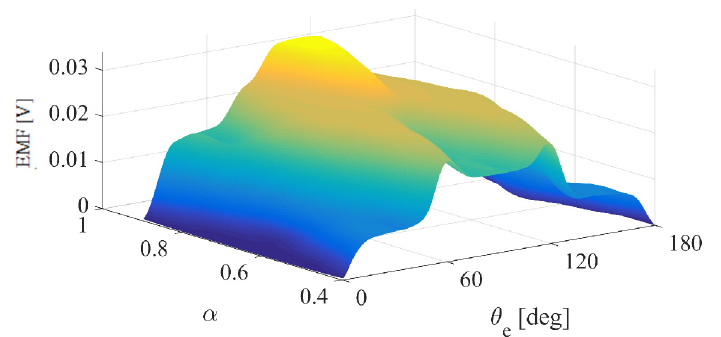
Figure 8. 12 poles line back-emf resampled surface.